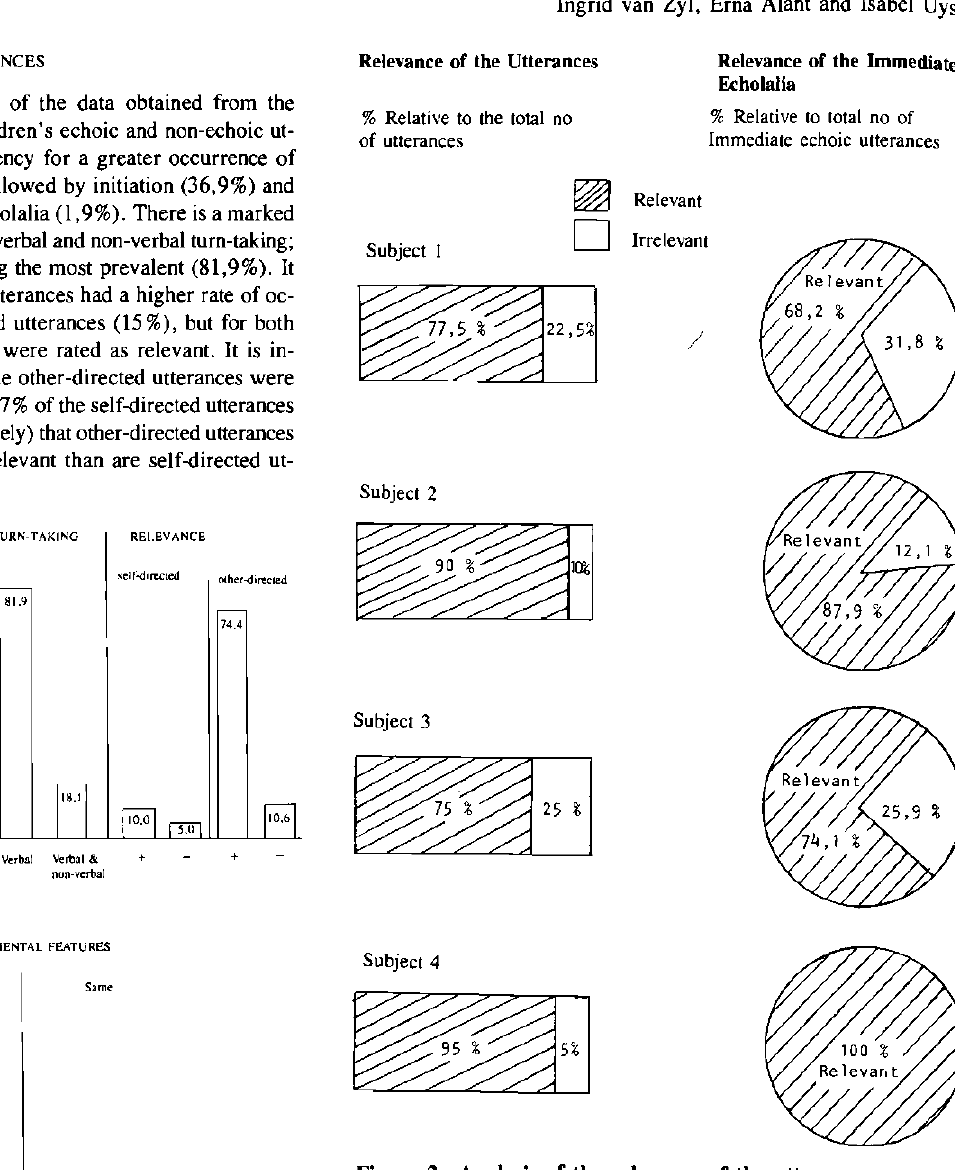
Figure 2 Analysis of the relevance of the utterances tween the ratings of relevance and of irrelevance. Of the immediate echolalia, 82,6% was relevant whereas only 17,5% was rated as ir-